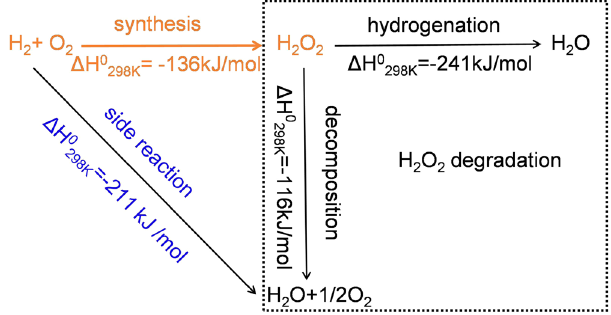
Fig. 1 | Schematic illustrationin the direct synthesis of H 2 O 2 . all reactions inthe direct synthesis of H 2 O 2 .